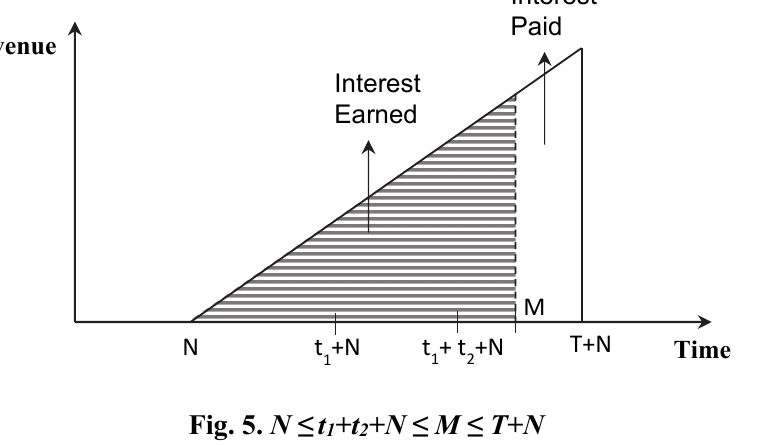
Fig. 5. N ≤ t 1 +t 2 +N ≤ M ≤